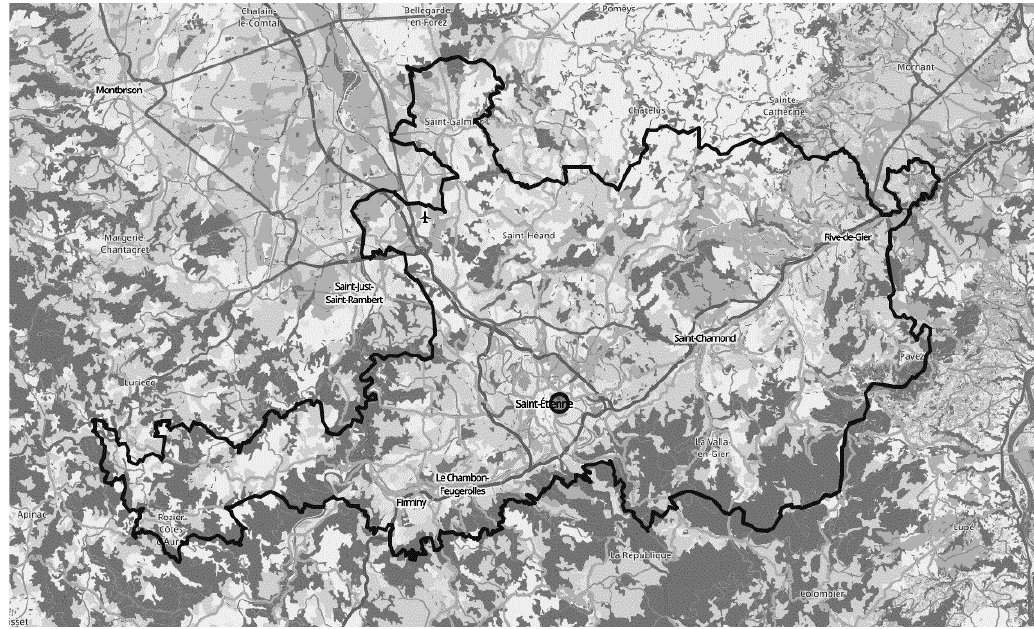
Figure 1. The current delimitation of Saint‐Étienne Métropole. Source: